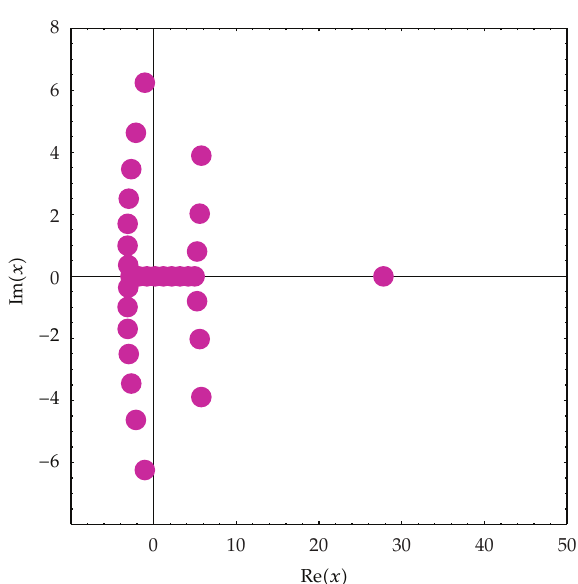
Figure 11: Zero of G 30 , 1 / 3 (cid:2) x (cid:3)